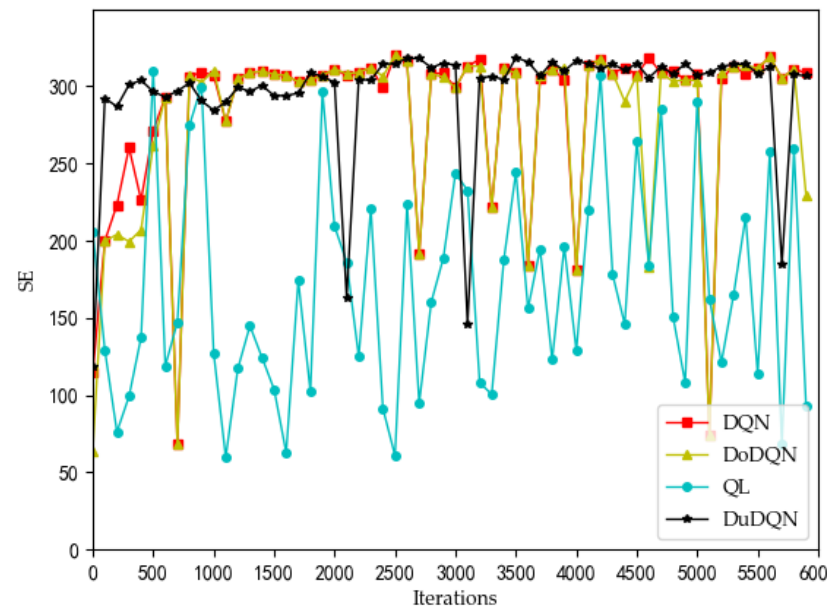
Figure 10. Comparison of SE using different methods (taking MVNO-1 as examples). For the curves of SE and system utility, the curves using the Dueling DQN algorithm have higher values than the curves of the other methods, and the curves converge and stabilize at the highest values (SE > 300, utility > 6). After 2200 iterations, the actual simulation data show that the SE obtained by the Dueling DQN algorithm is about 1% higher than that of the DQN algorithm, about 2.7% higher than the Double DQN algorithm, and about 76% higher than the QL algorithm. And utility has also been slightly